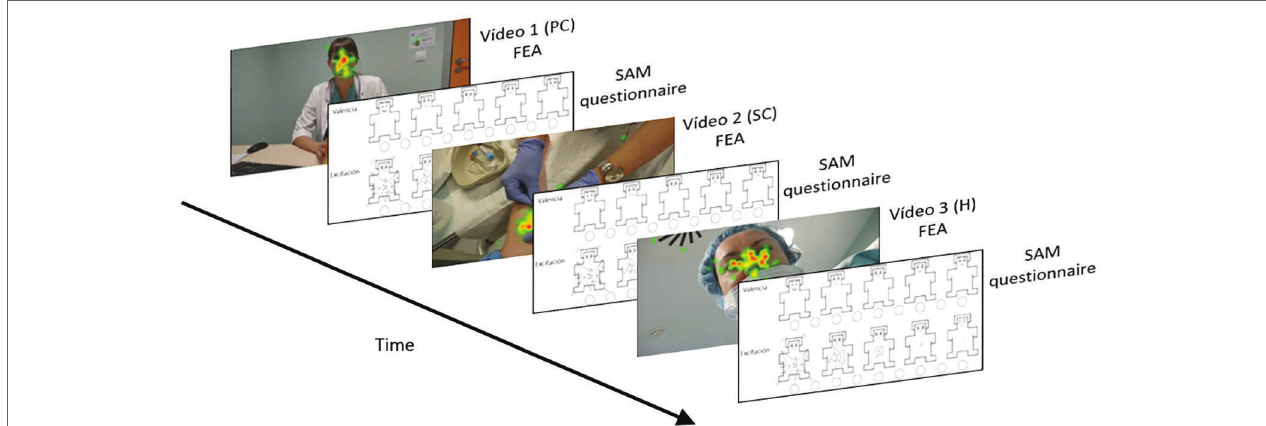
FIGURE 3 | Experimental